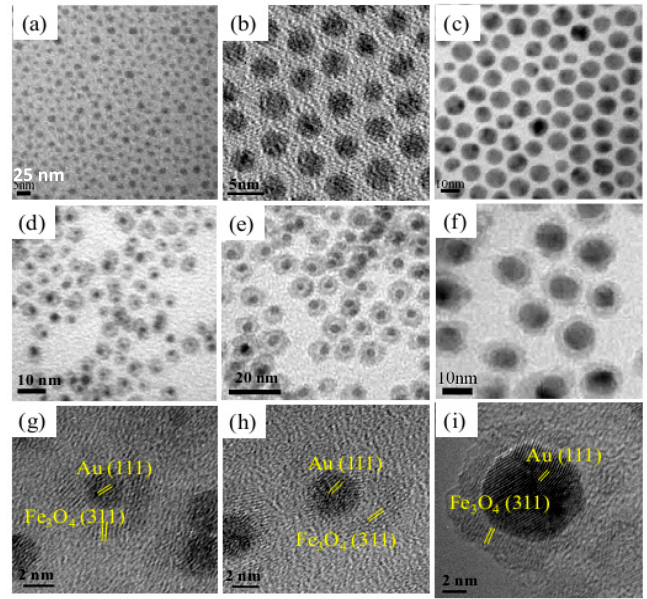
Figure 14. TEM images of Au NPs of ( a ) 2.5; ( b ) 4 and ( c ) 10 nm and the corresponding Au-Fe 3 O 4 yolk-shell NSs starting from ( d ) 2.5; ( e ) 4 and ( f ) 10 nm sized Au cores. High resolution micrographs of Au-Fe 3 O 4 yolk-shell NSs prepared starting from Au cores of ( g ) 2.5; ( h ) 4 and ( i ) 10 nm in size. Reproduced with permission from [79]. American Chemical Society,